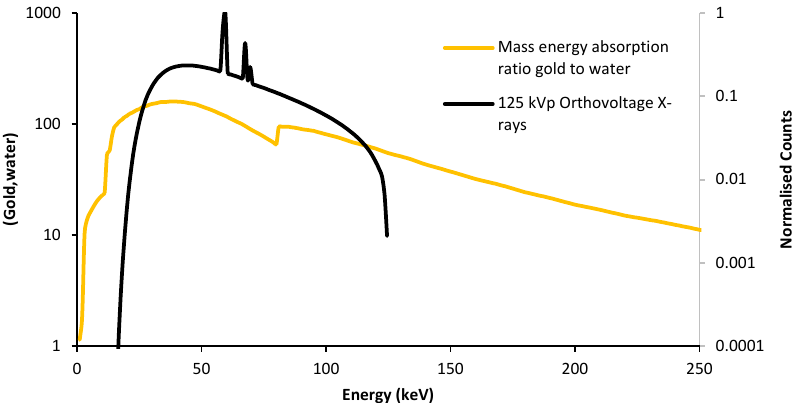
Figure 1. The ratio of mass energy absorption coefficient of gold compared to water against the orthovoltage filtration used (filter 4, 125 kVp) [27]. This was chosen as the optimal filter to increase the energy deposited by the interactions and hence increase dose enhancement.